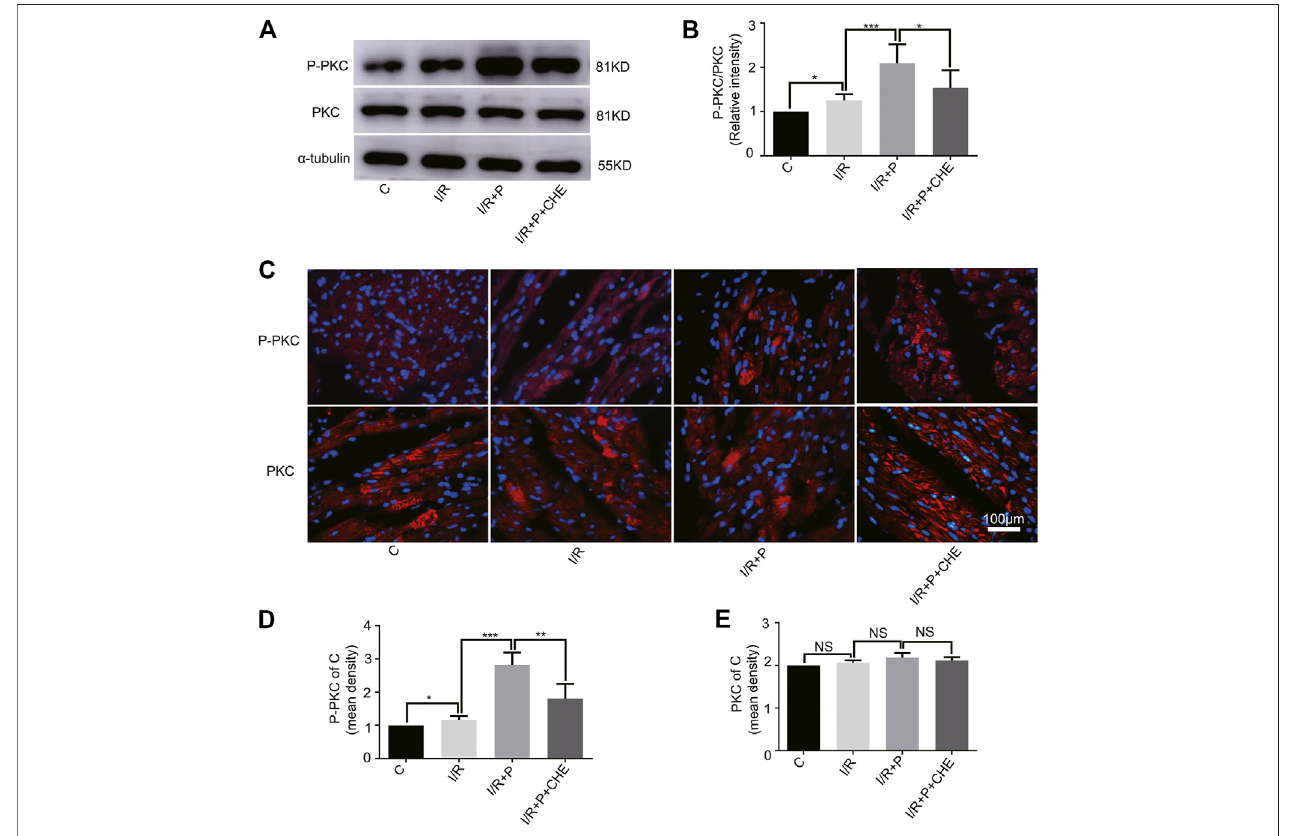
FIGURE 6 | Change of PKC activity by propofol. (A,B) . Expressions of PKC and P-PKC in myocardium based on the western blot assay. (C – E) . Expressions of PKCandP-PKCinmyocardiumbasedonimmuno fl uorescence.N (cid:1) 6.Dataareexpressedasthemean ± SD.Thescalebaris100um. Signi fi cancewascalculatedusing the ANOVA. p < 0.05 was considered statistically signi fi cant. * p < 0.05, ** p < 0.01, *** p < 0.001.